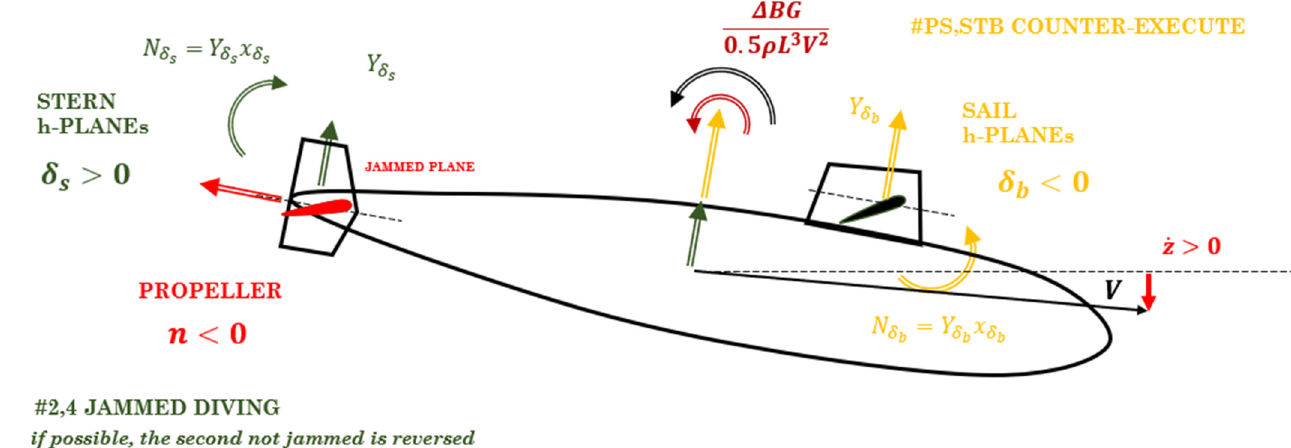
Figure A3. Dive fail forces.